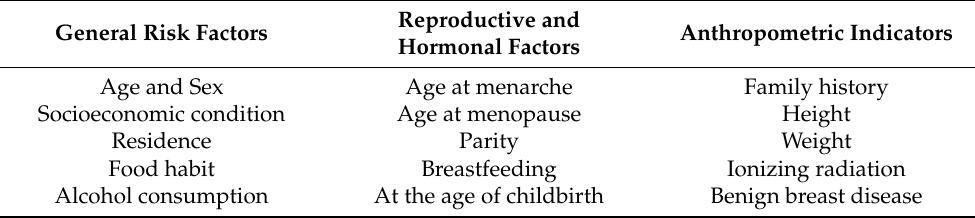
Table 2. Independent variables for breast cancer in Bangladeshi females.